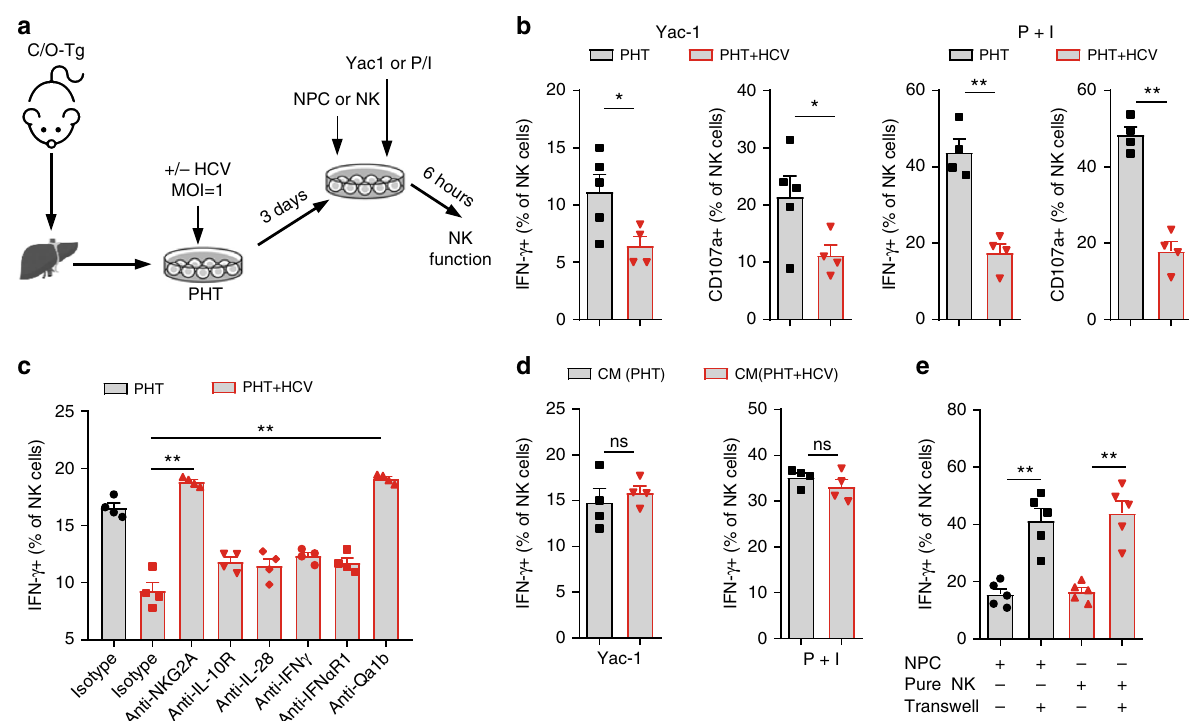
Fig. 5 HCV infection of hepatocytes impaired hepatic NK cells function. a Flowchart of NK functional inhibition assays. PHTs (2 × 10 5 /mL) isolated from naive C/O Tg mice were infected with HCVcc (MOI = 1) for 3 days before NPCs (1 × 10 6 ) were added. Yac-1 cells (1 × 10 5 /well) or PMA (50 ng/mL) plus ionomycin (1 μ M) were used to stimulate NK cells. b FACS analysis of intracellular IFN- γ and CD107a of NK cells 6 h after stimulation. c Indicated blocking antibodies and isotype IgG were added to the PHT/NK co-culture assay. IFN- γ expression of NK cells was detected 6 h after Yac-1 cell stimulation. d Measurement of intracellular IFN- γ in NK cells after supernatants of PHTs after HCV infection (HCV-CM) were added to NPCs. Yac-1 cells (1 × 10 5 /well) or PMA (50 ng/mL) plus ionomycin (1 μ M) were used to stimulate NK cells. e NPCs or MACS puri fi ed intrahepatic NK cells were co-cultured with or transwell separated from HCV-infected PHTs. IFN- γ expression of NK cells was detected 6 h after Yac-1 cell stimulation. Data were mean ± SD, Student t -test. * P < 0.05; ** P < 0.01. ns Not signi fi cant. Source data are provided as a Source Data fi